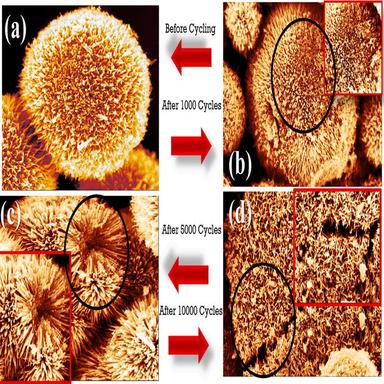
SEM images of before and after cycles.